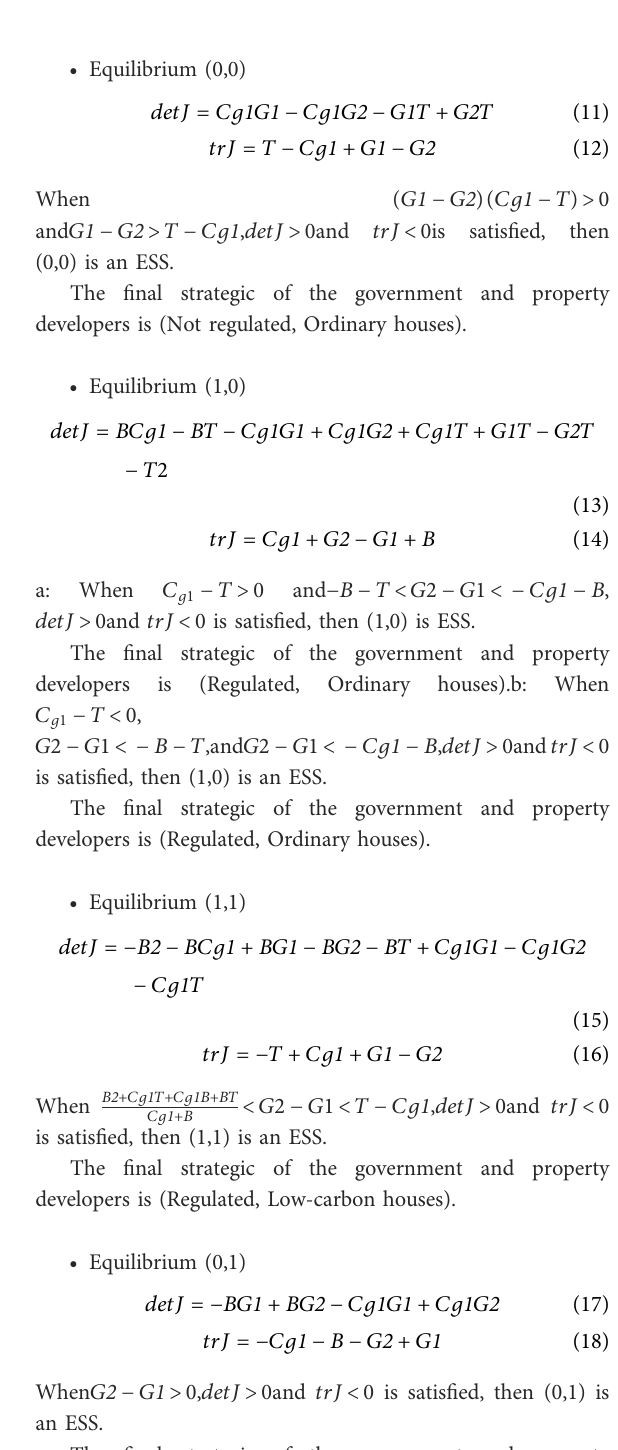
The fi nal strategic of the government and